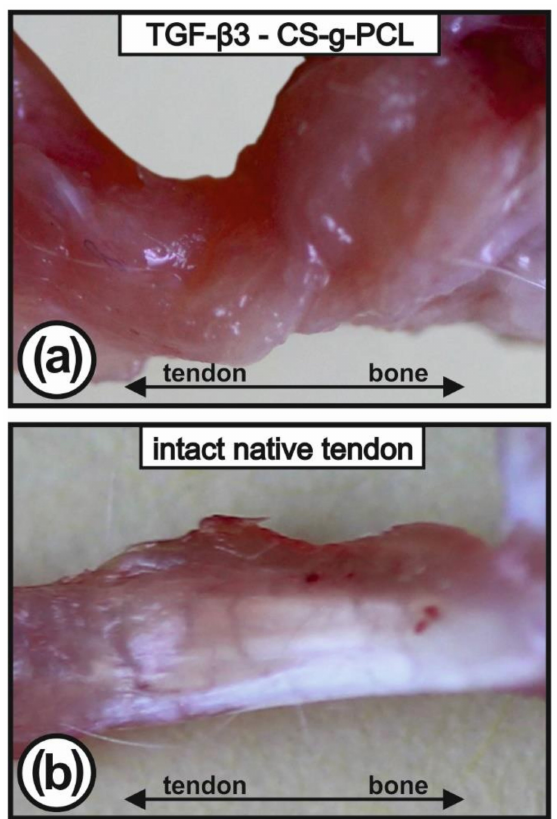
Figure 1. Macroscopic view of the explanted infraspinatus tendons (surgical site with TGF– β 3 – CS–g–PCL sca ff old ( a ); intact native tendon ( b )). The left tendons are ensheathed by repair